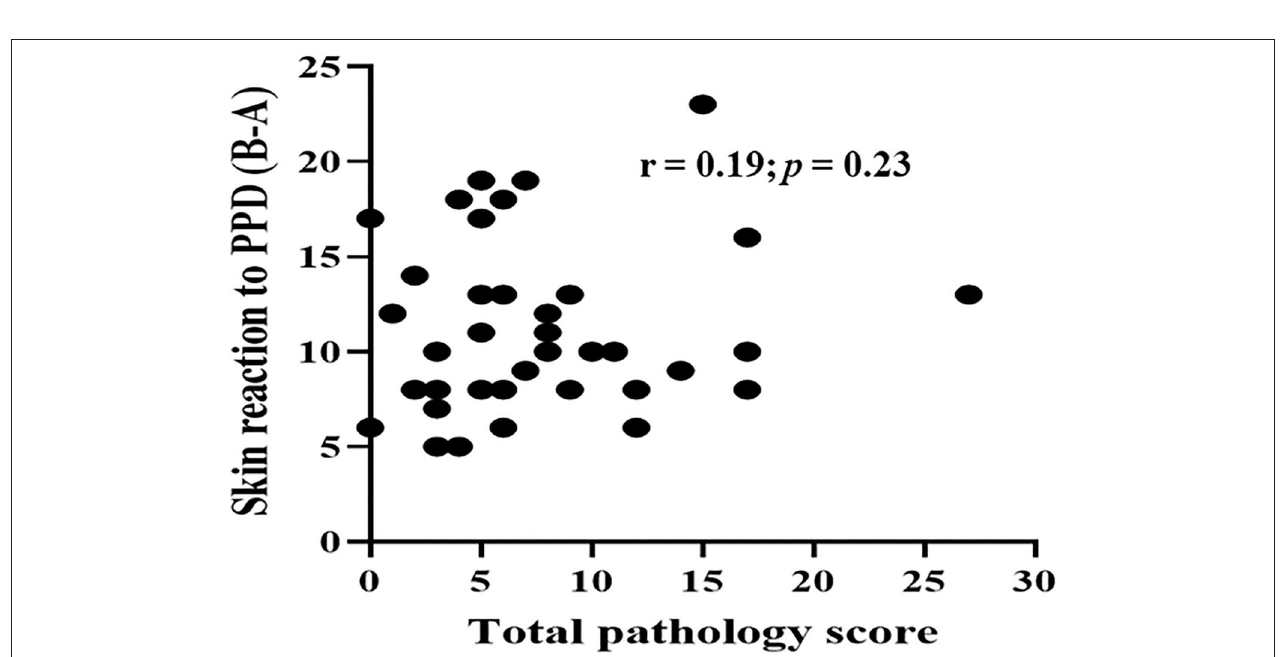
FIGURE 2 | Correlation between skin reactivity and pathology score of the 43 study animals. Spearman correlation was to estimate the correlation between skin reaction to PPD (B-A) and pathology score of the 43 reactors. The correlation between two was not significant ( r = 0.19; p = 0.23).